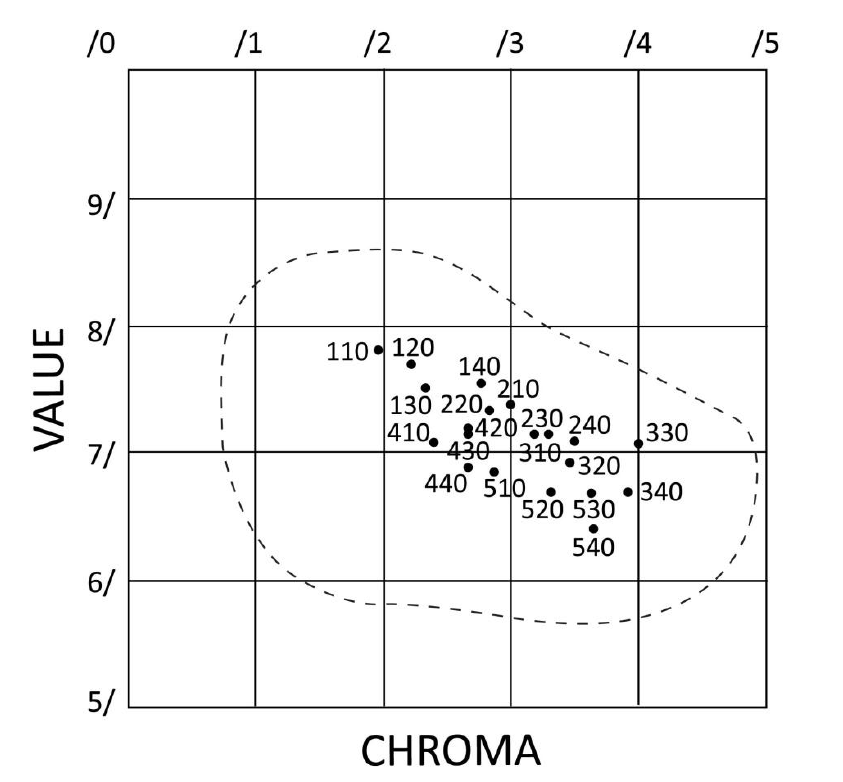
Figure 2. A plot of the Munsell value and chroma for the master Chromascop shade guide. Note the dotted outline of color distribution of human teeth as plotted in a previous study